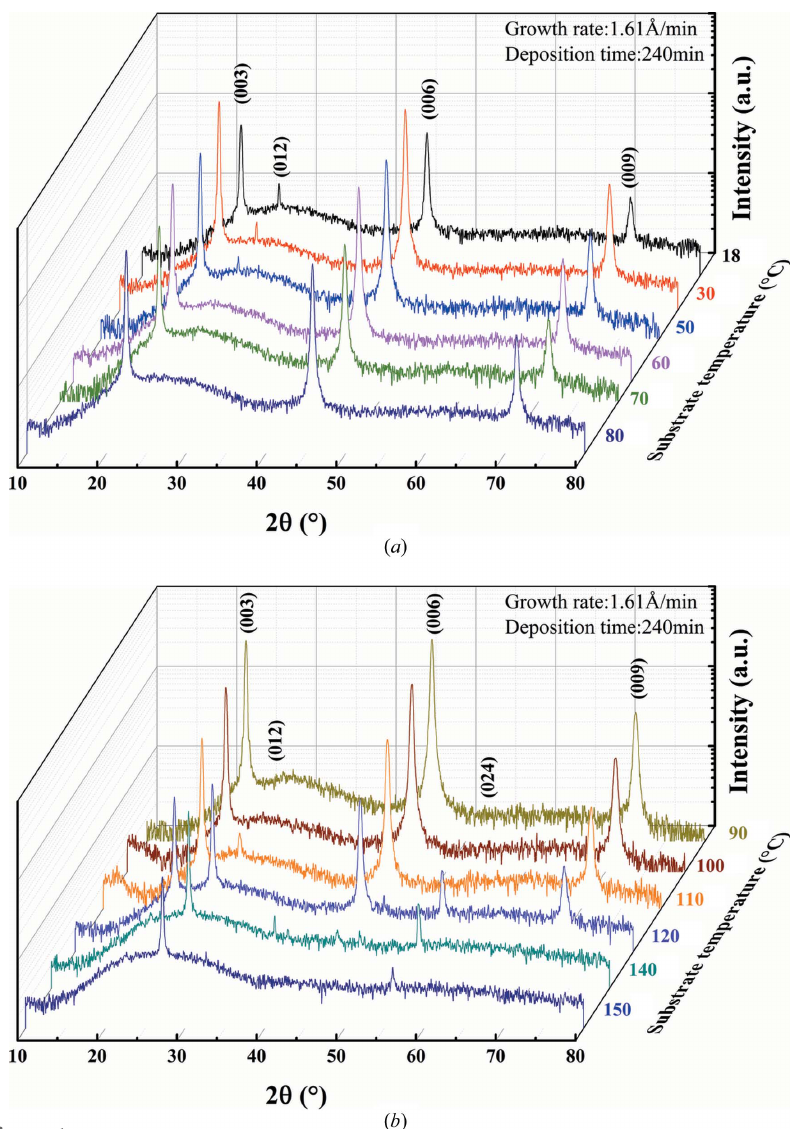
Figure 1 XRD patterns of Bi thin films on glass at different substrate temperatures (the growth rate is 1.61 A˚ min (cid:5) 1 and the deposition time is 240 min). ( a ) The XRD patterns of Bi thin films at substrate temperatures of 18, 30, 50, 60, 70 and 80 (cid:2) C and ( b ) the XRD patterns of Bi thin films at substrate temperatures of 90, 100, 110, 120, 140 and 150 (cid:2)